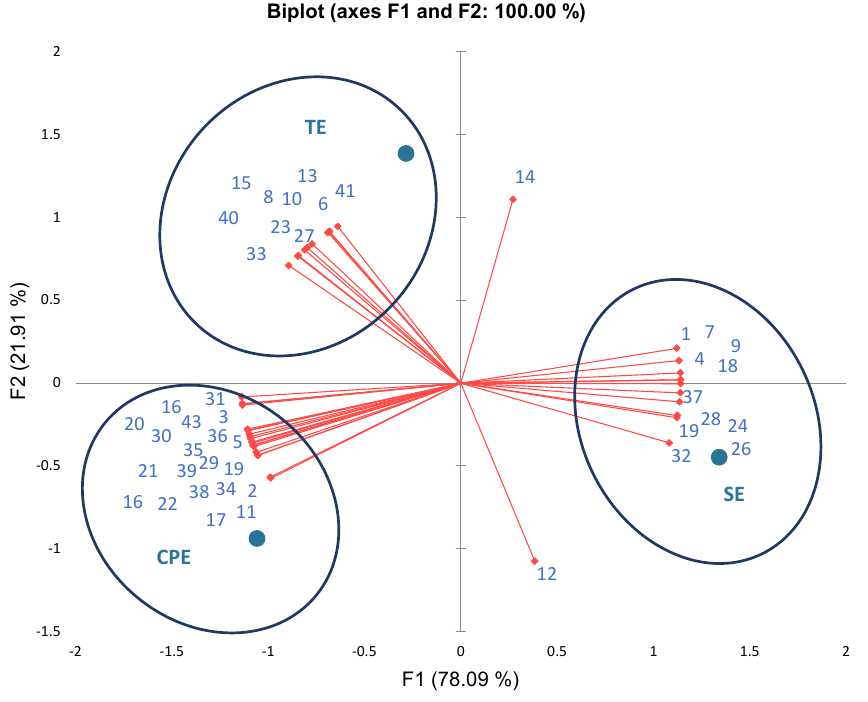
Figure 2. PCA biplot of shea butter .